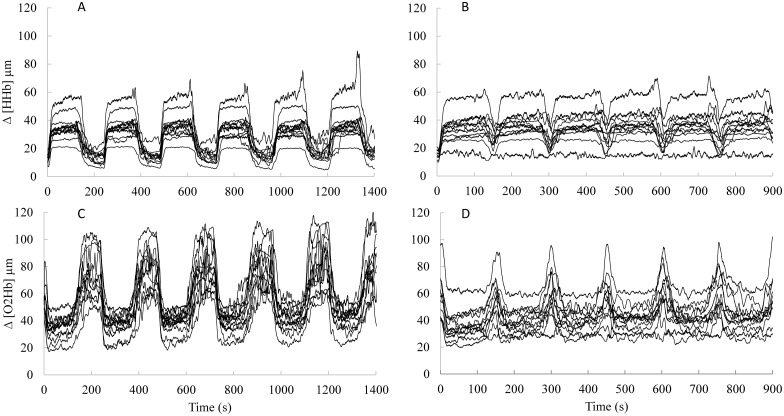
Individual oxygenation changes during the SSG sessions.Panel (A) Δ [HHb] during REC-120. Panel (B) Δ [HHb] during REC-30. Panel (C) Δ [O2Hb] during REC-120. Panel (D) Δ [O2Hb] for REC-30.